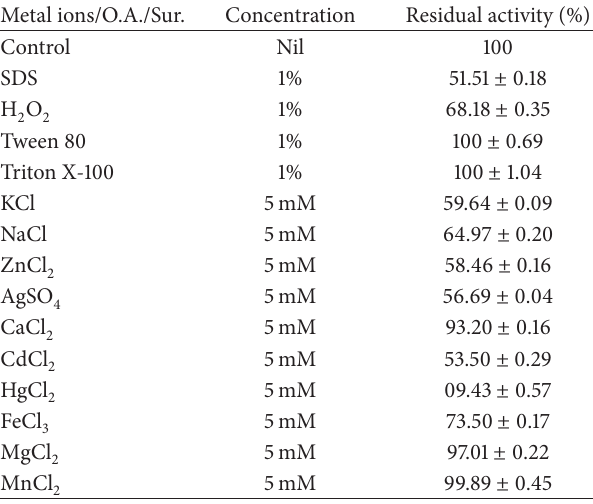
Table 2: Effect of various organic solvents on proteolytic activity.